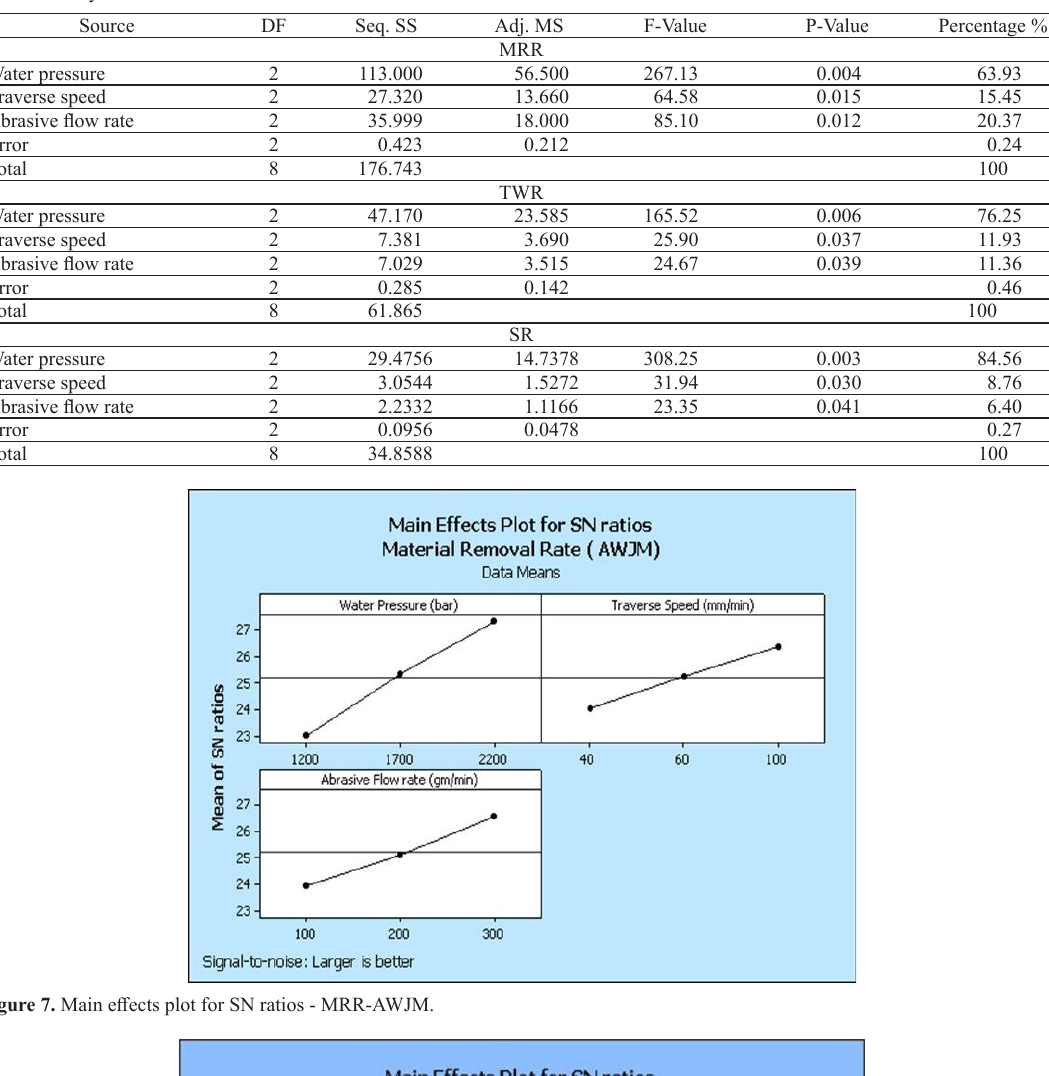
Table 6. Analysis of variance -